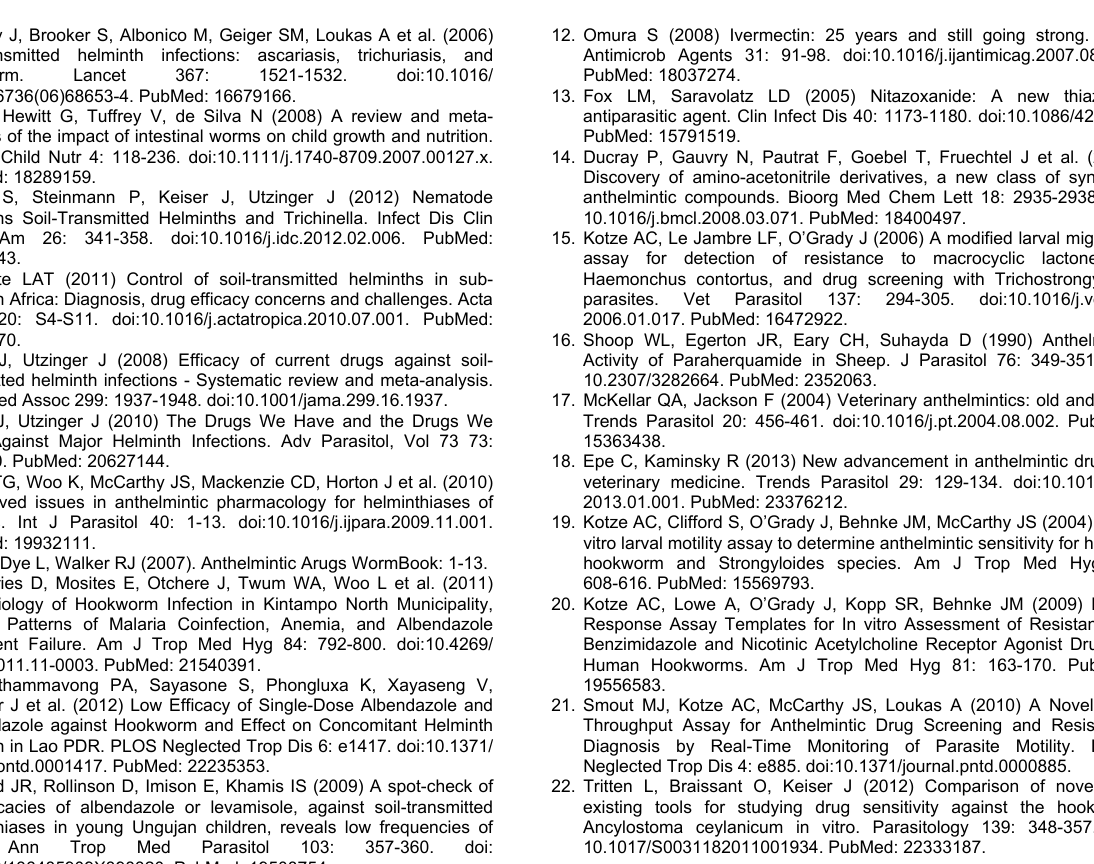
were scored daily for motility on a scale of 3-0. Data are from the same experiments in Figure 3.